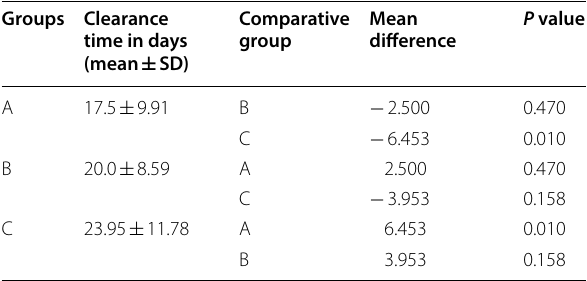
5 patients (2.1%) in Group B and 20 patients in Group C (8.3%) had incomplete stone clearance, but the difference was statistically insignificant ( P 0.143) (Table 4). =